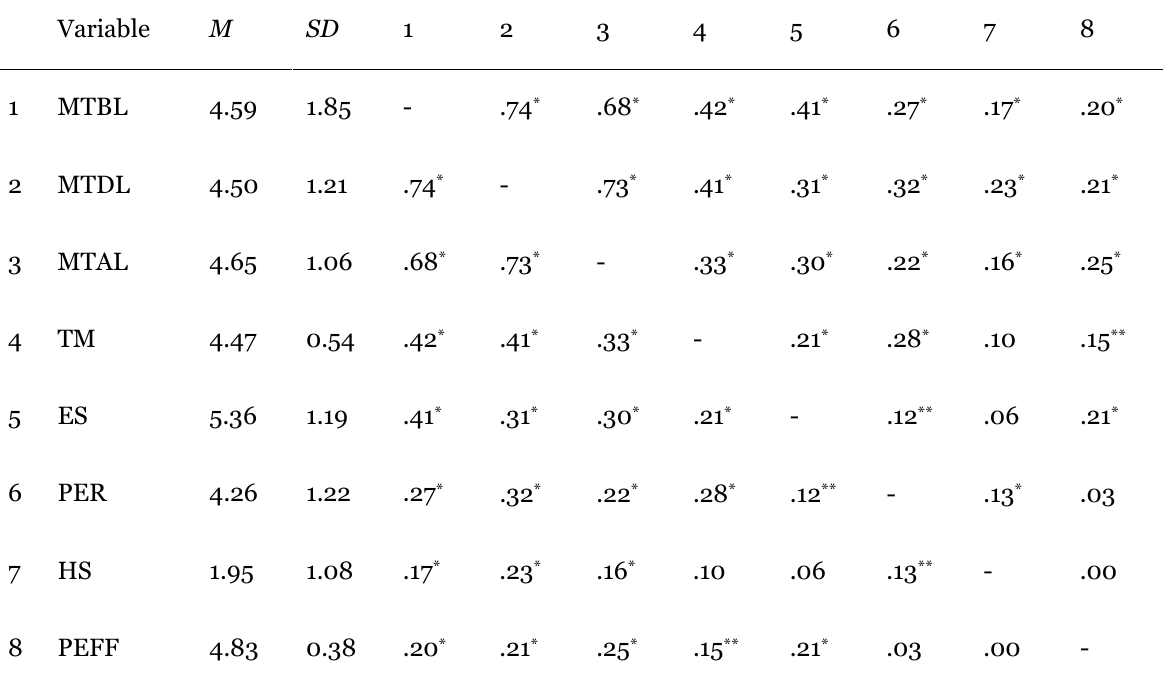
Means, Standard Deviations, and Pearson Correlations for Sub-SRL Strategies and Perceived